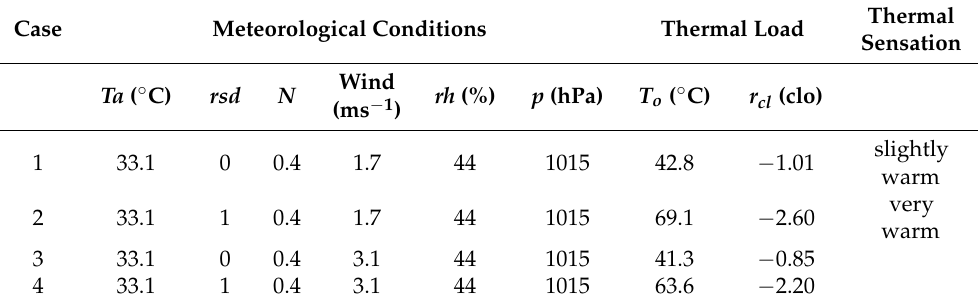
Table 4. Meteorological conditions, thermal load and thermal sensation characteristics in Martonv á s á